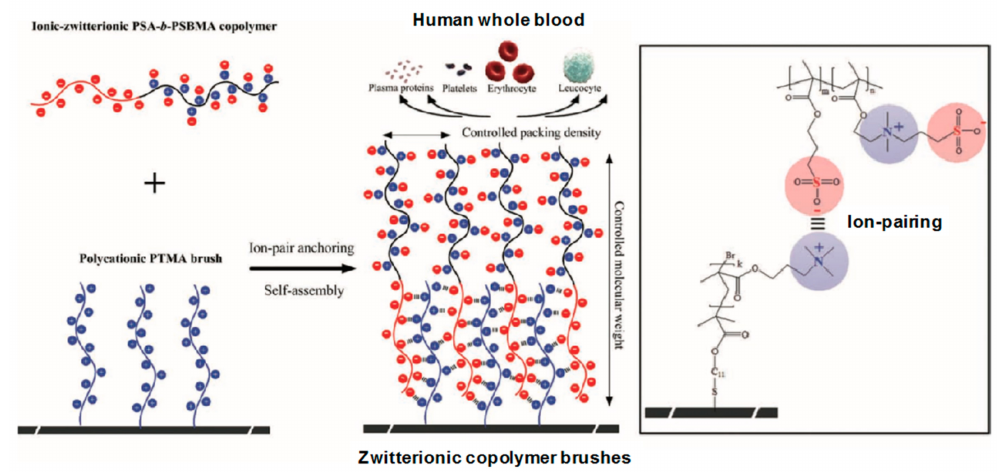
Figure 7. Ion-pair anchoring of zwitterionic copolymer brushes on the membrane surface. Reproduced with permission from Reference